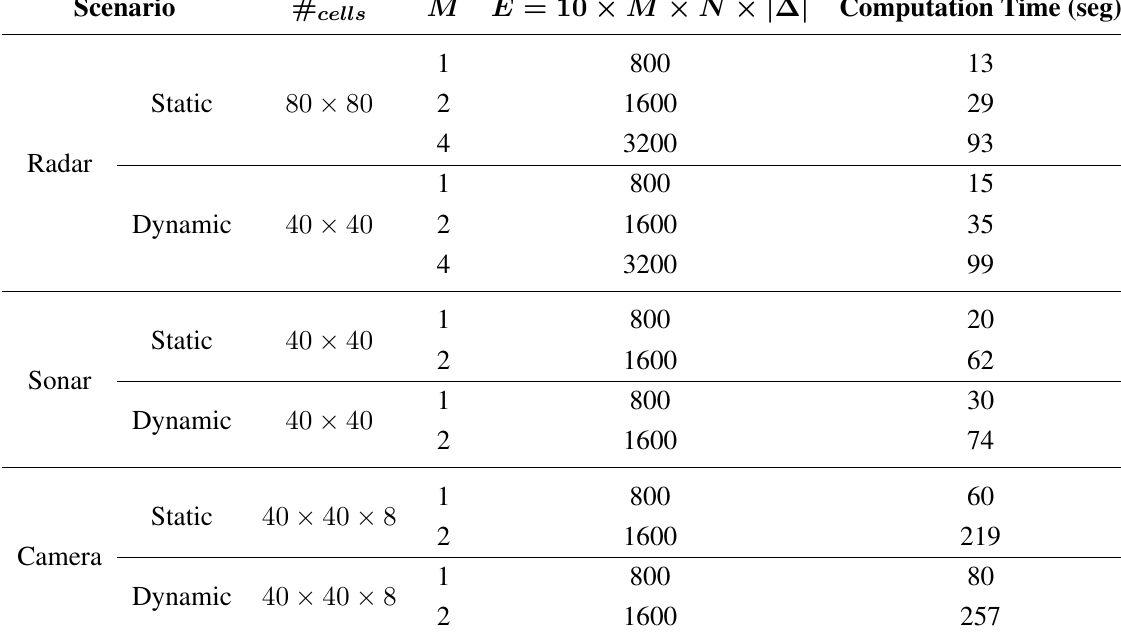
Table 1. Computations cost of the controller for the scenarios (with N = 10 and | ∆ | = 8 ).